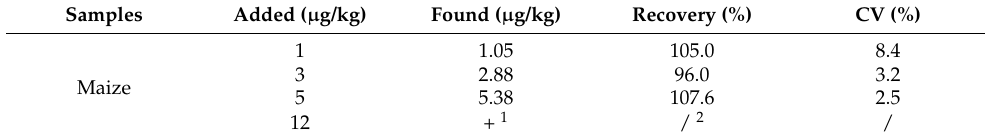
Table 3. Accuracy and precision of PMs-ICA for detection of AFB 1 in maize samples ( n = 3).